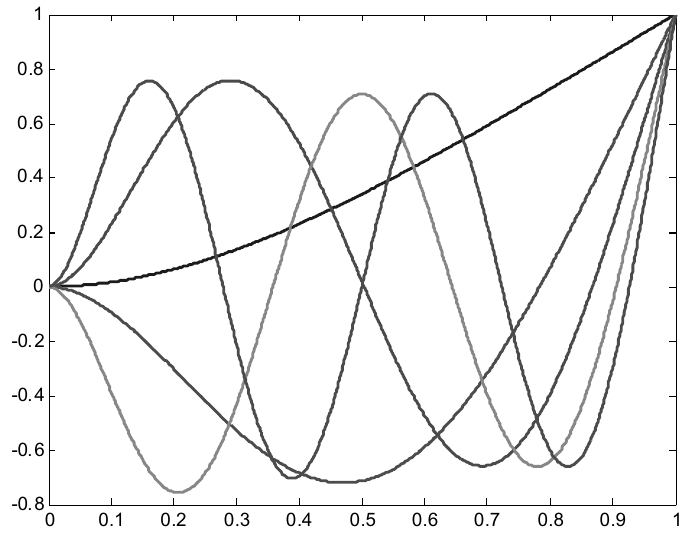
Fig. 18. First 5 mode shapes of the cantilever